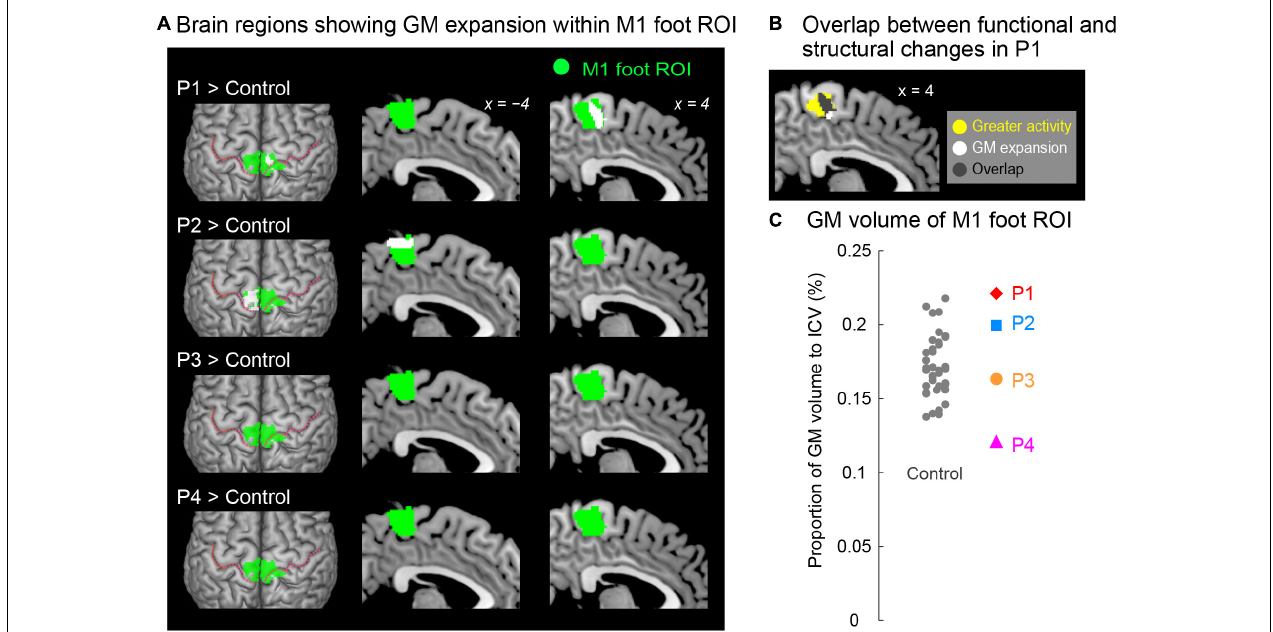
FIGURE 4 | (A) Results from contrast analysis for GM volume. Significant clusters of voxels (white sections) showing GM expansion within the M1 foot ROI when compared with the control participants are shown. Only participants P1 and P2 showed a significant cluster (white sections) in the M1 foot ROI (green sections). These sections are superimposed on the MNI standard brain. The top view, and sagittal slices (x = –4 and 4) are shown in each row. In each top view panel, pink dotted lines indicate the central sulci. (B) Overlap (gray section) between the M1 foot section in which participant P1 showed significant GM expansion (white and gray sections) and the region where she showed significantly greater activity during the bimanual task than the control participants (yellow and gray sections). (C) Individual GM volume in the M1 foot ROI. A vertical axis indicates the proportion of GM volume in the ROI to ICV. None of paraplegic participant showed significant difference from the control participants. A red diamond, blue rectangle, orange circle, and pink triangle represent the data obtained from paraplegic participants P1, P2, P3, and P4, respectively. Gray dots represent the data obtained from the control participants, and these are horizontally jittered to avoid over-plotting. GM, gray matter; M1, primary motor cortex; ROI, region-of-interest; ICV, intracranial volume; MNI, Montreal Neurological